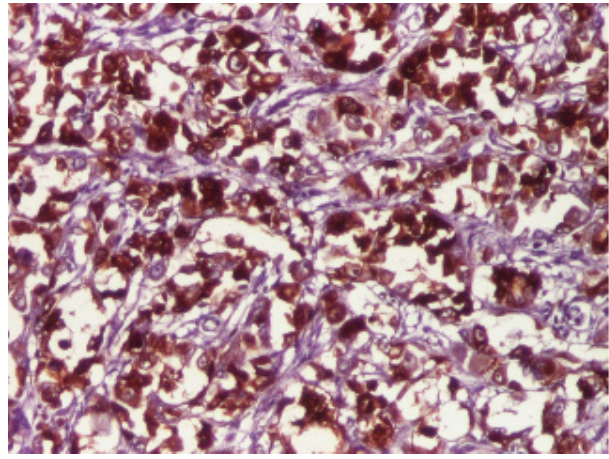
Figure 7. Immunohistochemical expression of AE1_AE3 showed a diffuse strong staining in tumor cells, ×100.